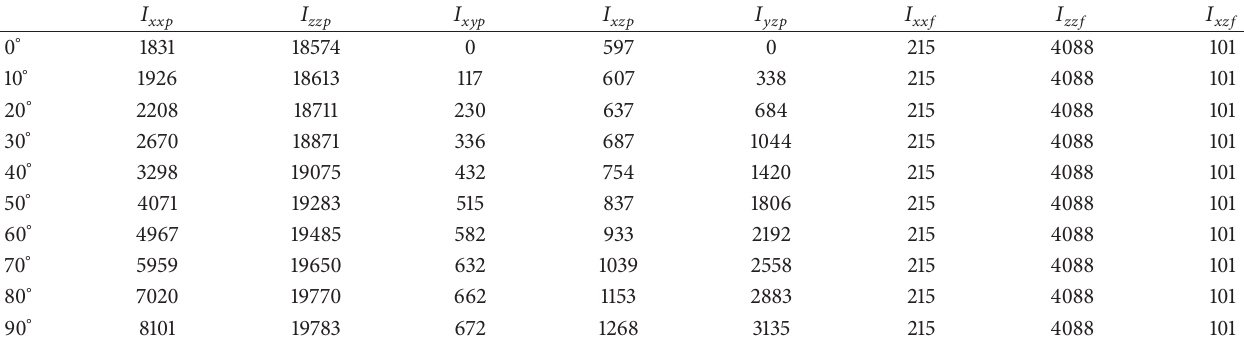
Table 1: The inertia tensors of the pendulum mass and the fixed liquid mass when the liquid fill level is 0.2.